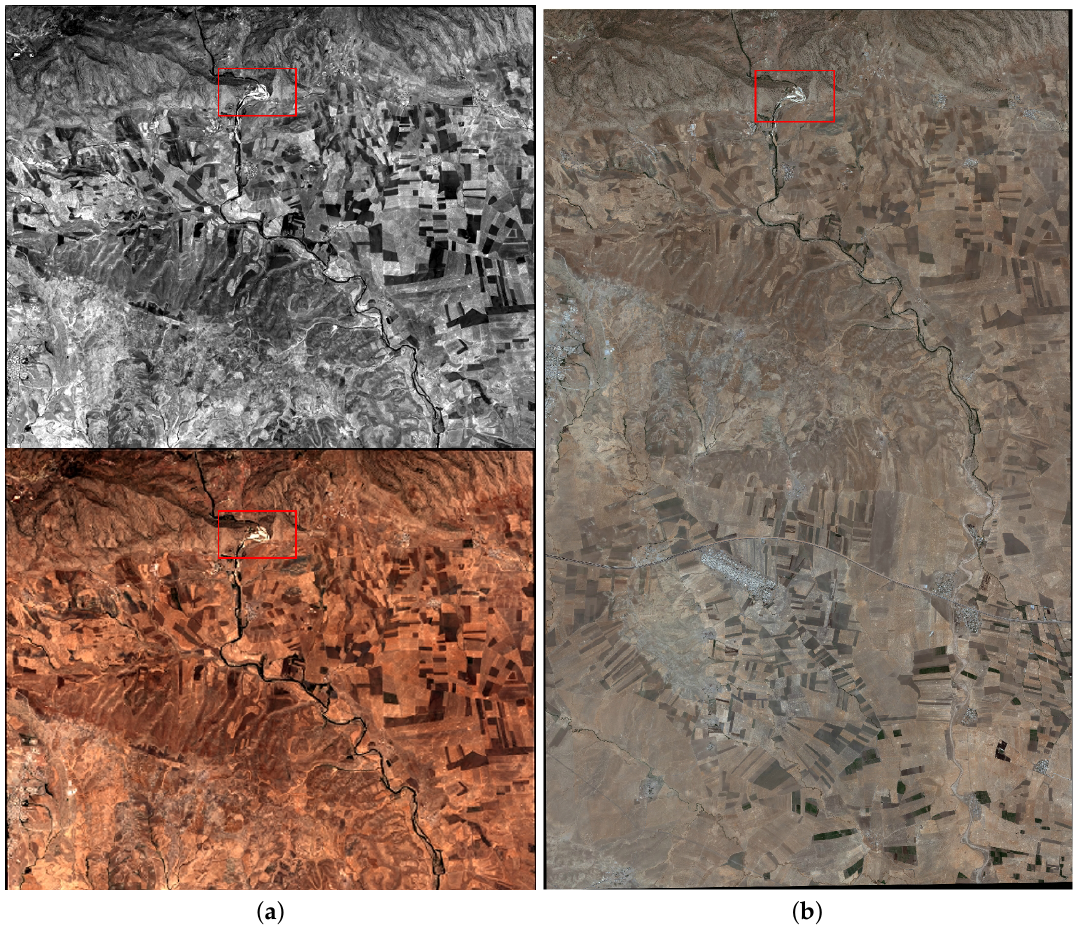
Figure 4. The input images arising from Pleiadés. Image ( a ) represents the panchromatic and multispectral original images (northern part); and ( b ) the pansharpened one. The red rectangle indicates a quarry inside the Khinis area, particularly important for the project; this subset of the image was studied due to its high